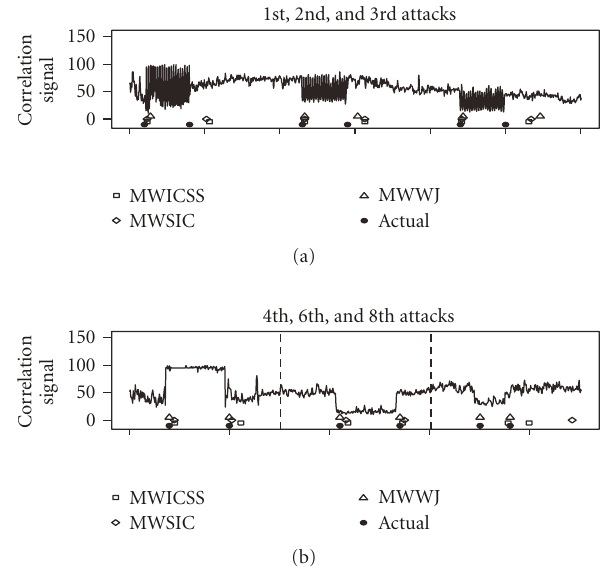
Figure 7: Detection of tra ffi c distortion attacks within TCP tra ffi